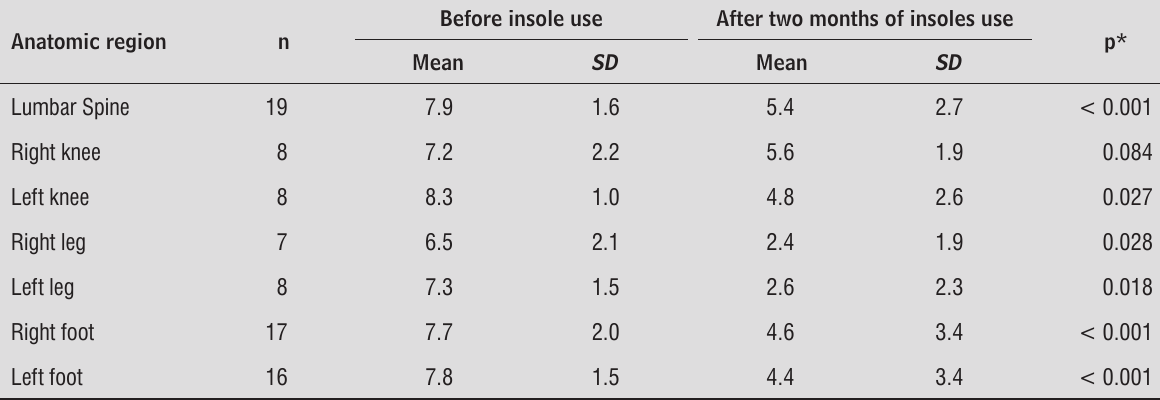
Table 2 - Absolute frequency (n), mean and standard deviation (SD) for pain before and after two months of insole use by obese adults, according to the anatomic region. Joinville, SC, Brazil, 2010